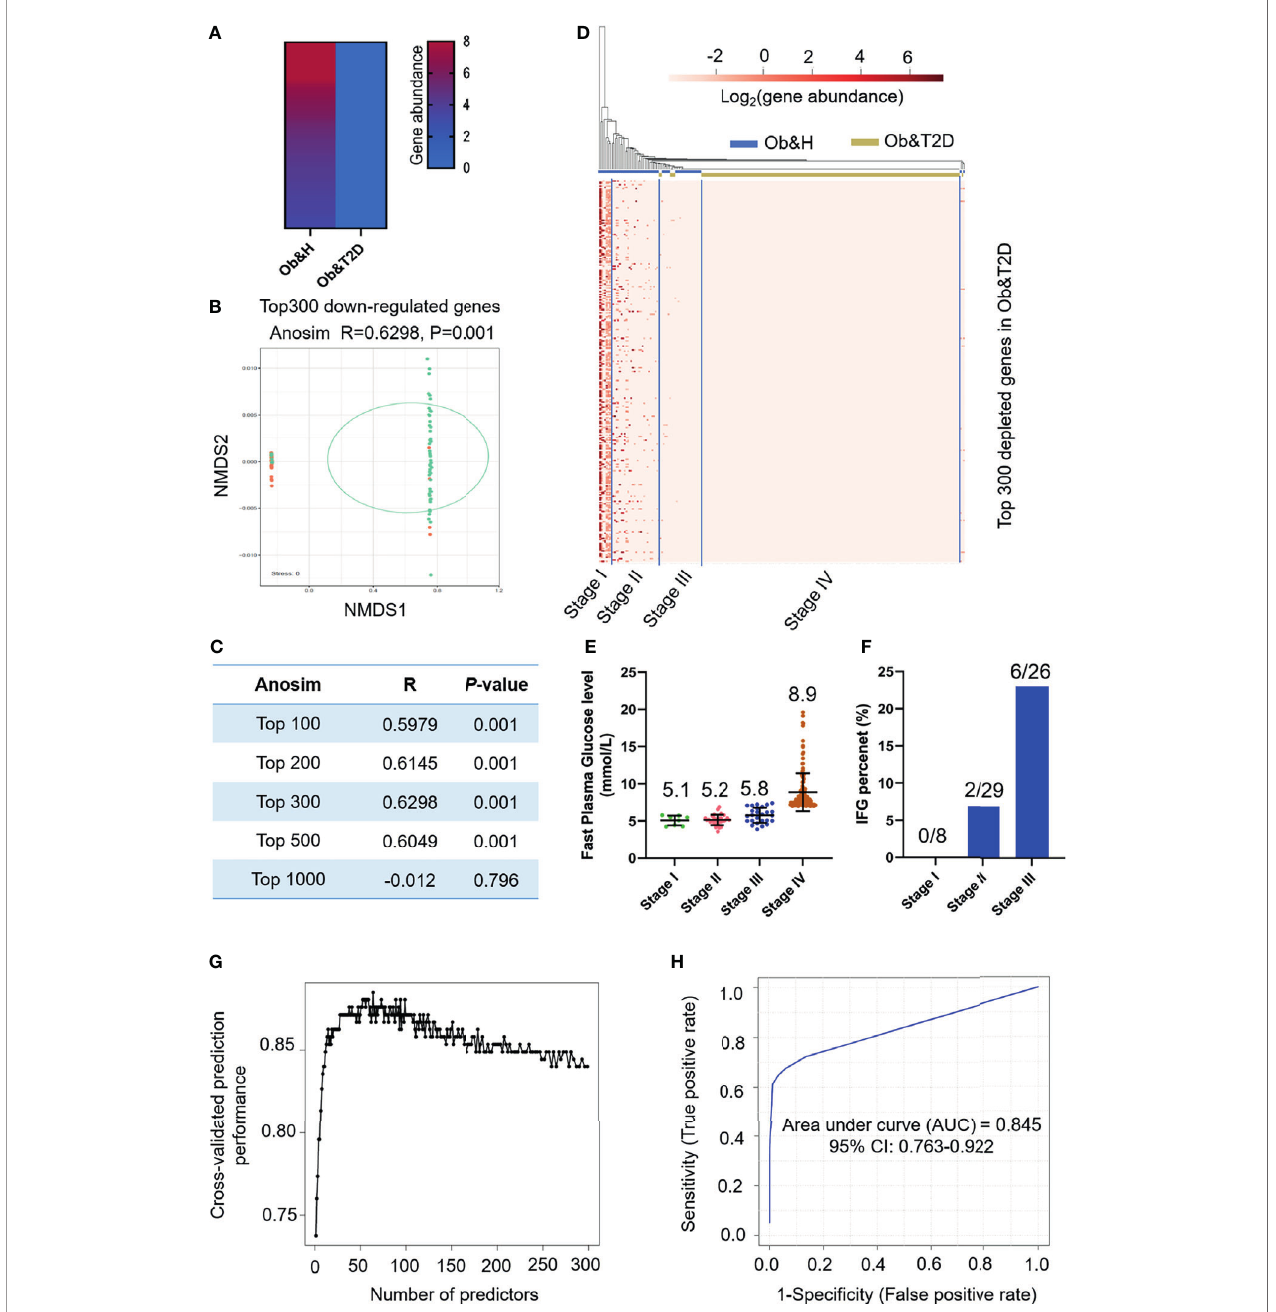
FIGURE 5 | Distinguishing obese and type 2 diabetes (Ob&T2D) from obese and healthy (Ob&H) based on differentially enriched gut microbial genes. (A) Heat map depicting the gene abundance of the top 300 [rank by log 2 (fold change)] Ob&T2D-depleted genes in both groups. (B) Nonmetric multidimensional scaling based on the Bray – Curtis distance of the top 300 depleted gene abundance in Ob&T2D. ANOSIM, R = 0.6298, P = 0.001. (C) Listing of ANOSIM analysis R, P , and stress values based on the abundance of top N ( N = 100, 200, 300, 500, and 1,000) depleted genes in Ob&T2D. (D) Heat map displaying the gene abundance of the top 300 [rank by log 2 (fold change)] Ob&T2D-depleted genes in each participant. The samples were grouped into four stages (stages I – IV) according to their gene abundance. (E) Dot plots presenting the fasting plasma glucose levels in the individuals of each stage. The number of each stage is as follows: stage I ( n = 8), stage II ( n = 29), stage III ( n = 26), and stage IV ( n = 159). (F) Percentage of people with impaired fasting plasma glucose levels (6.1 mmol/L<fasting plasma glucose level<7 mmol/L). (G) Classi fi cation performance of a random forest model using the abundance of the top 300 depleted genes as assessed by R random forest package. (H) Receiver operating characteristic curve displaying the classi fi cation for Ob&H and Ob&T2D using gene abundance pro fi les. AUC, area under